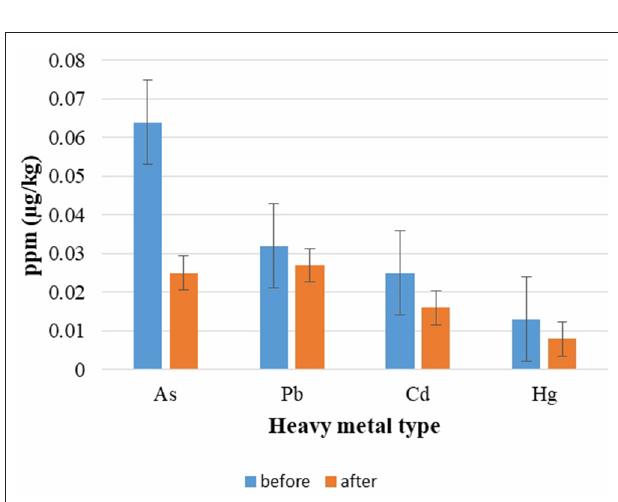
FIGURE 5 | Testing results of heavy metals before and after implementation of ISO 22000:2018. *Considerably diverse between two groups of before and after implementation ( p <